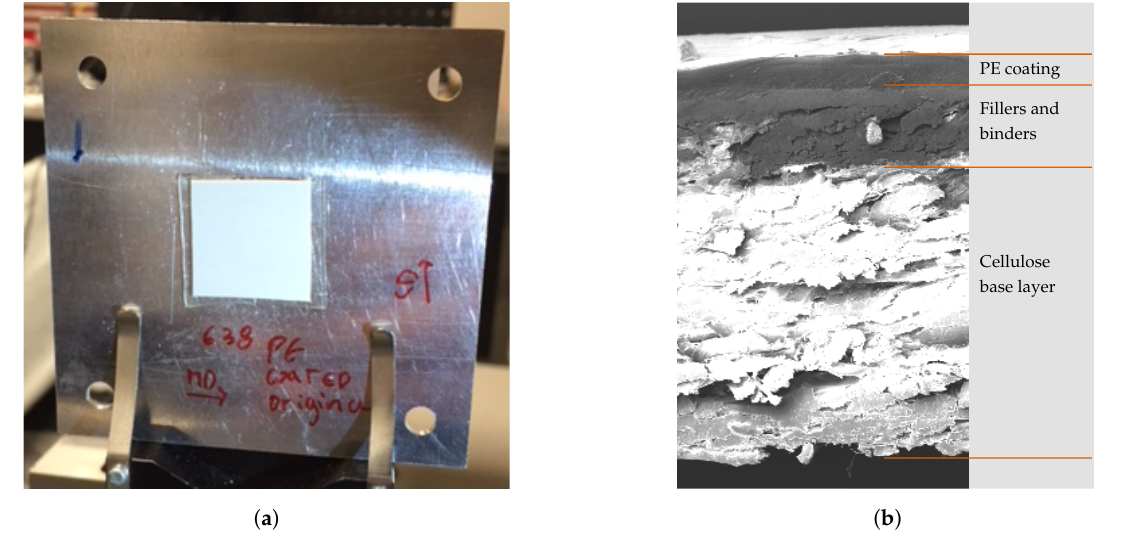
Figure 1. ( a ) adapted 20 × 20 mm sample illuminated by the optical system. ( b ) scanning electron microscope (SEM) cross- section image, (working distance 10-mm, field-of-view 200- µ m), of PE-coated paperboard. The paperboard is composed of a multi-ply cellulose material, a coating layer of binders and fillers, and a top PE-coating layer with an average thickness of 13 µ